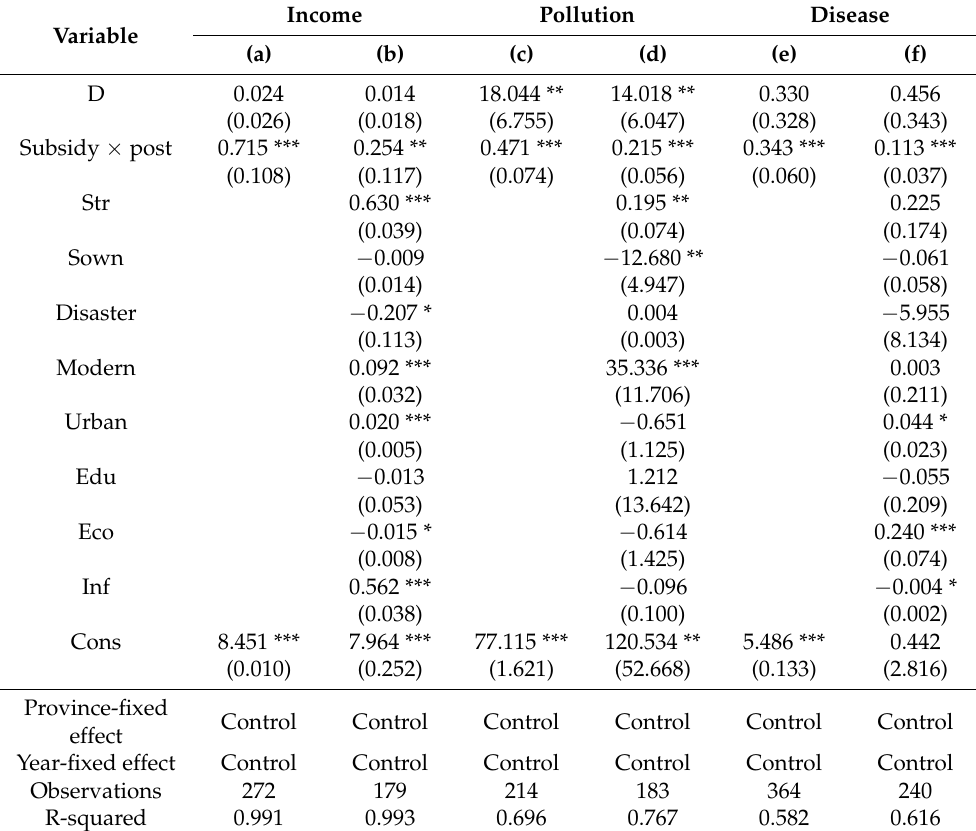
Table 7. The results of continuous